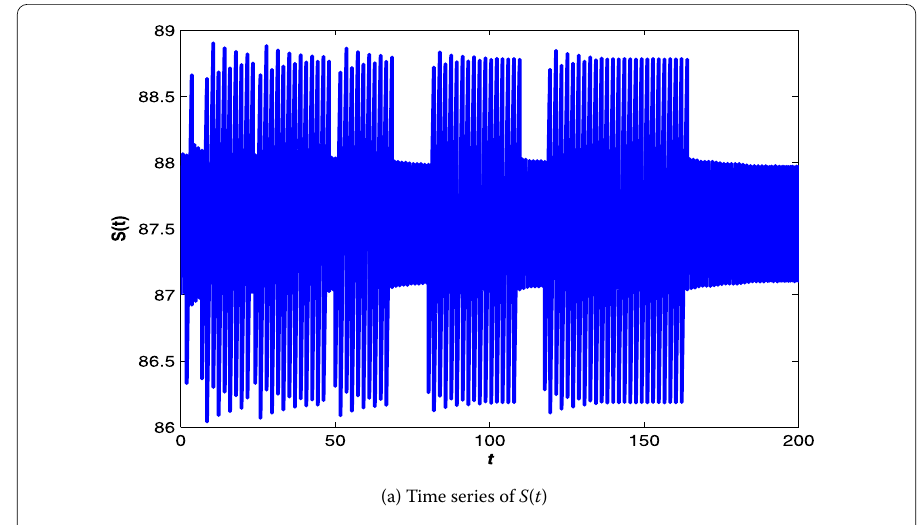
Figure 3 The chaotic solution of model (2.5) with RL = 20 < I ∗ = 27.33 and p max = 0.01 < p ∗ = 0.38. The initial value is ( S 0 , I 0 , R 0 ) =